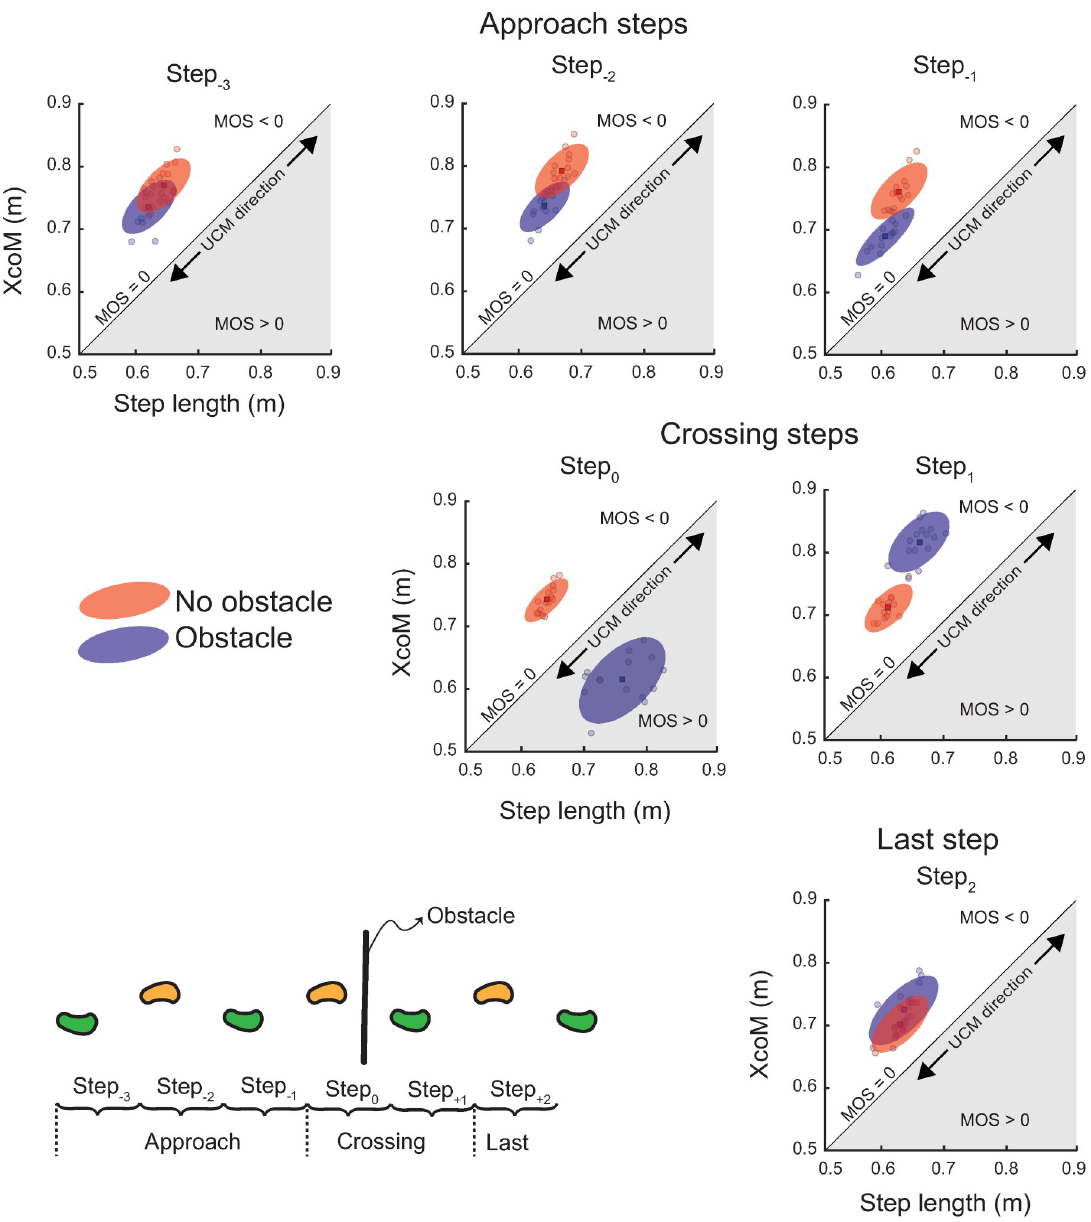
Fig 2. Representative data from one participant. Figure illustrates changes in various outcomes while approaching and crossing an obstacle, and then resuming unobstructed gait (blue ellipses). Steps during unobstructed gait are included for comparison (red ellipses). The 45˚ line separates the regions of positive and negative MOS AP . The 45˚ line also represents the direction of the uncontrolled manifold (UCM). Variations in step length and XcoM along this direction do not change MOS AP . The ellipses are centered at the centroid of the across-trial data for each step, and the major axes are aligned with the 45˚ line. However, the flatness of the ellipses is representative. Changes in mean values of the MOS AP are reflected in the position of the ellipses in each chart. The flatness of the ellipse reflects the synergy index, with flatter ellipses indicating higher synergy indices that reflect stronger covariation between the step length and